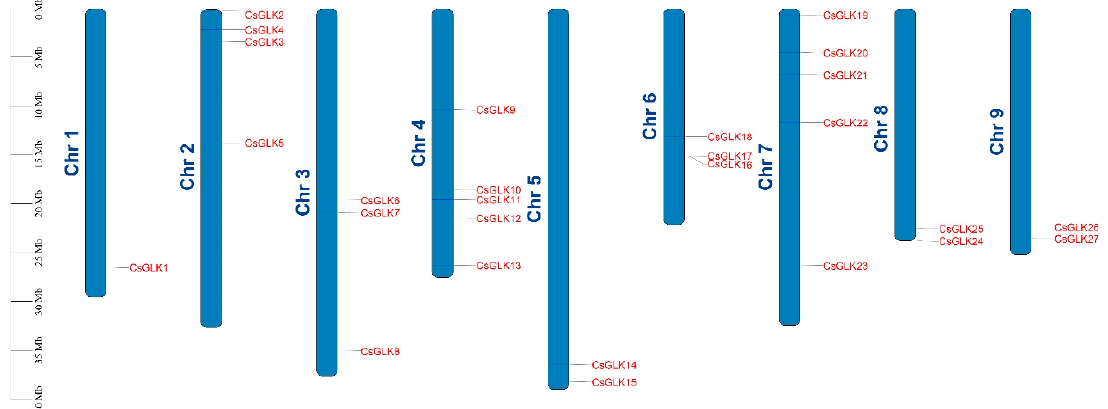
Figure 4. Chromosomal distribution of GLK genes in Citrus. The scale represents 40 Mb chromoso- mal distance.